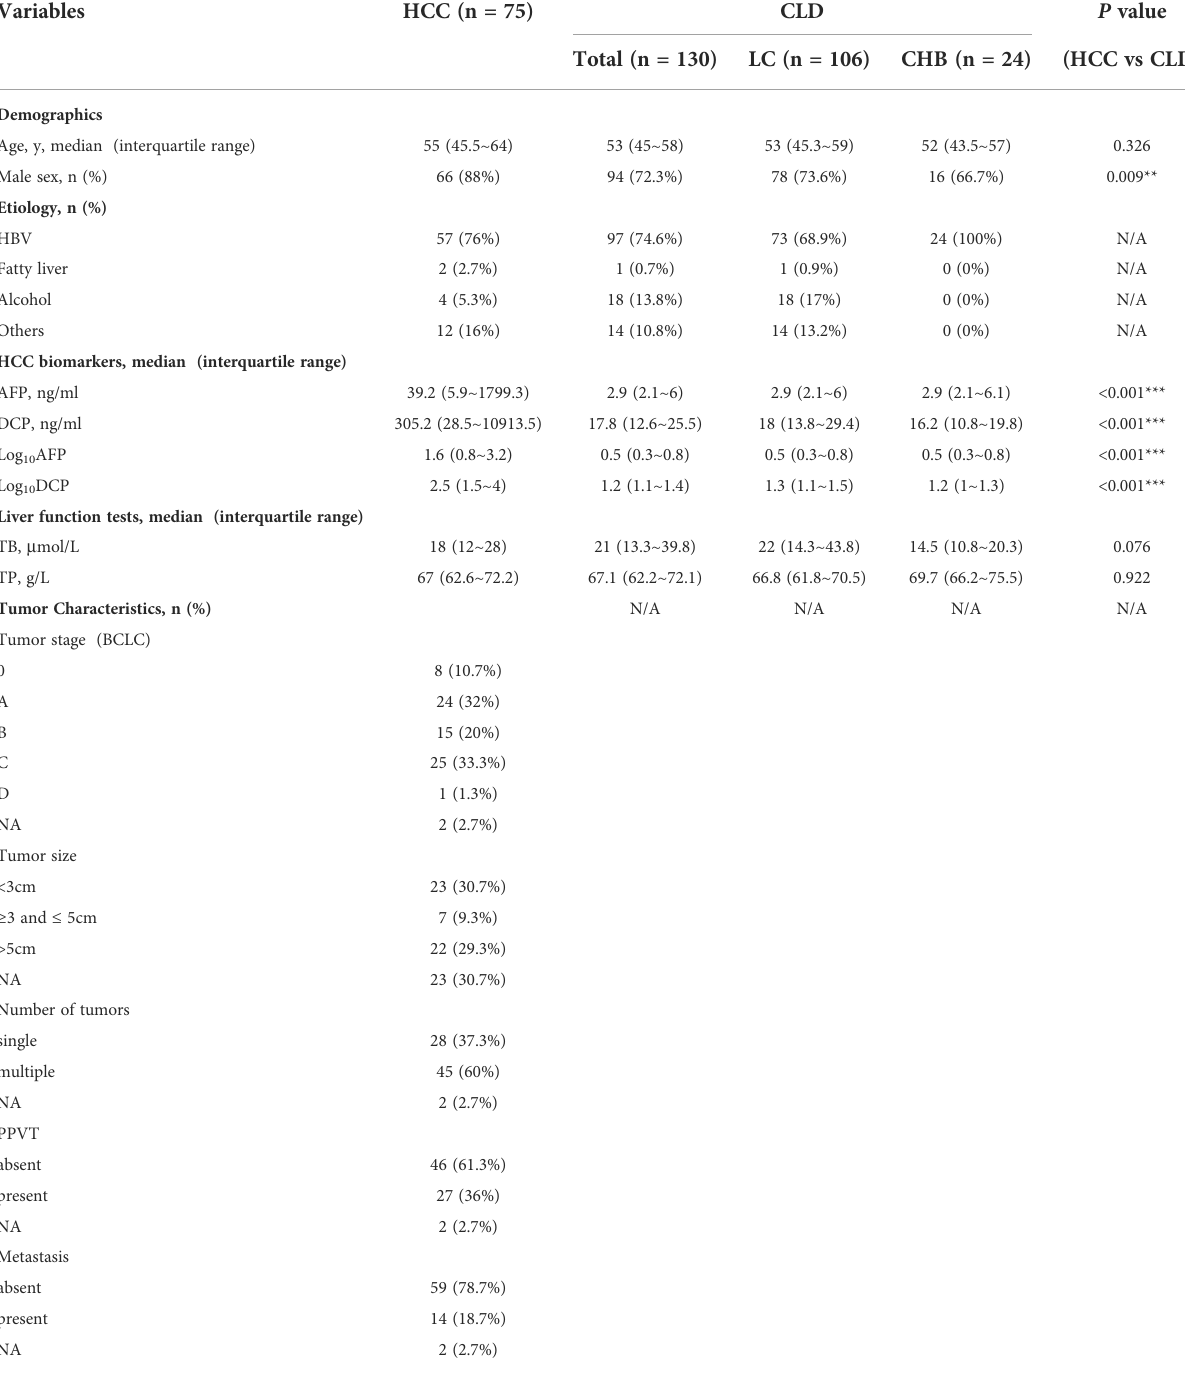
TABLE 5 Characteristics of patients used to test the GAADPB